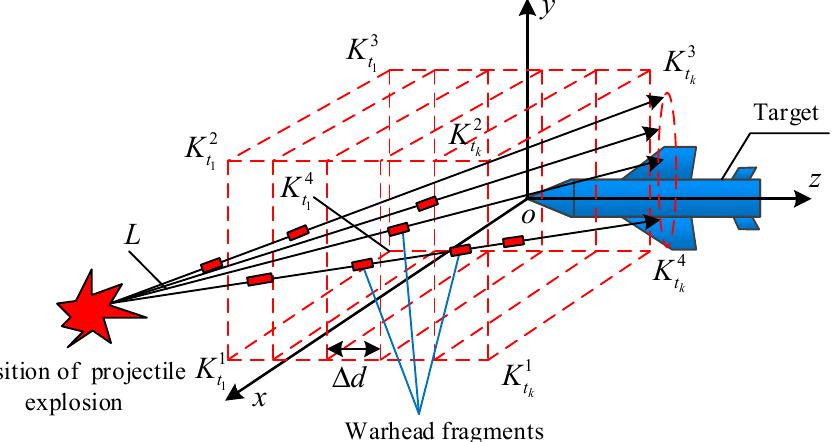
Figure 1. Schematic diagram of target damage test.